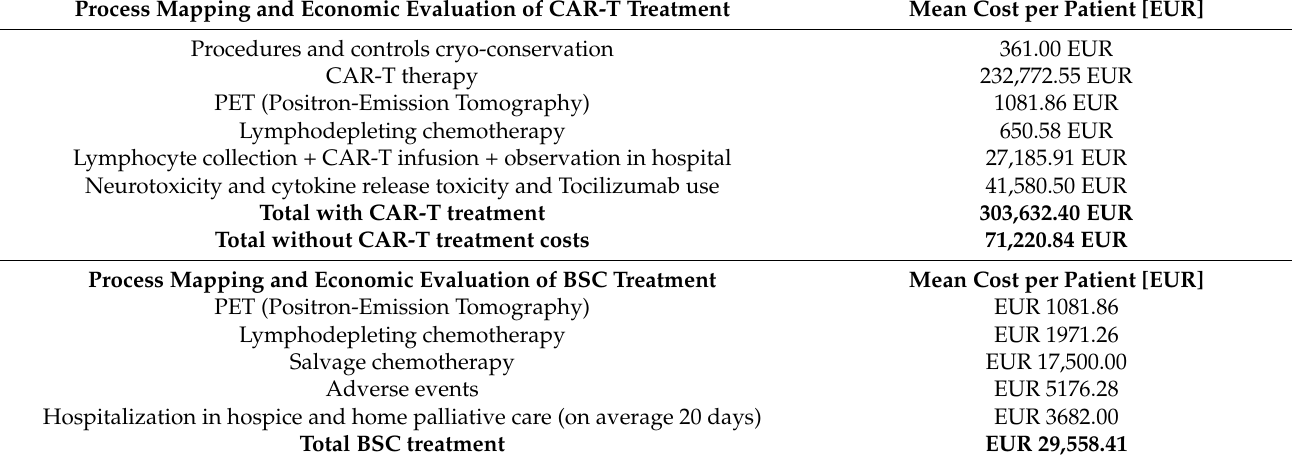
Table 4. CAR-T and BSC treatment: process mapping and economic evaluation of the clinical pathways.